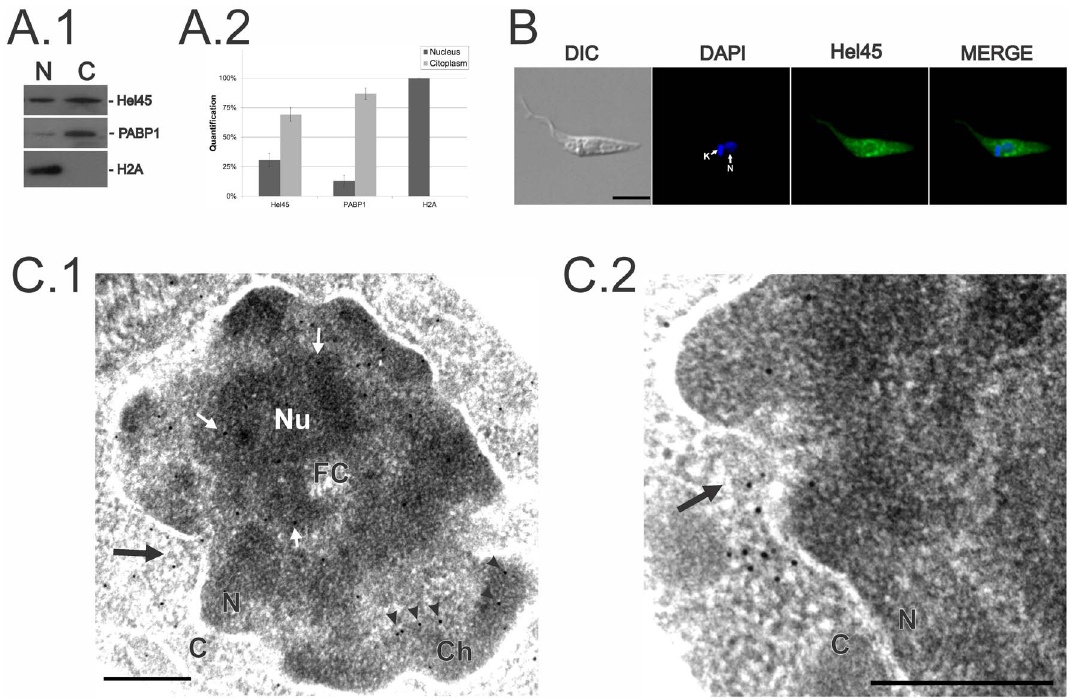
Figure 3. Cellular localization of Hel45 in Trypanosomacruzi epimastigotes. (A.1) Representative results of three independent western blots with cellular extract. N=nuclear extract. C=cytoplasmic extract. PABP1 was used as a cytoplasmic marker and histone H2A was used as a nuclear marker. (A.2) Quantification of western blots by densitometry. Data are expressed as means and standard deviation. (B) Detection of Hel45 by indirect immunofluorescence. DIC=differential interference contrast. DAPI=DNA stained with DAPI. Hel45= endogenous Hel45. MERGE=merged DAPI and immunofluorescence images. N=nucleus. K=kinetoplast. Bar=5 m m. (C.1 and C.2) Ultrastructural microscopy by immunocytochemistry with anti- Hel45 antibodies and 10 nm colloidal gold-coupled anti-mouse IgG. Black arrows=Hel45 labeling on the cytoplasmic side of the NPC. White arrows=Hel45 labeling in perinucleolar regions. Arrowheads=Hel45 labeling in electron-dense chromatin. Nu=nucleolus. FC=nucleolus febrile center. Ch=electron-dense chromatin. N=nuclei. C=cytoplasm. Bar=0.2 m m.